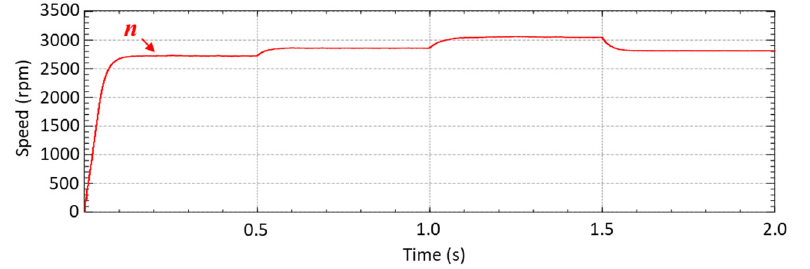
Figure 17. Simulation results of the electric machine speed for different mechanical loads.